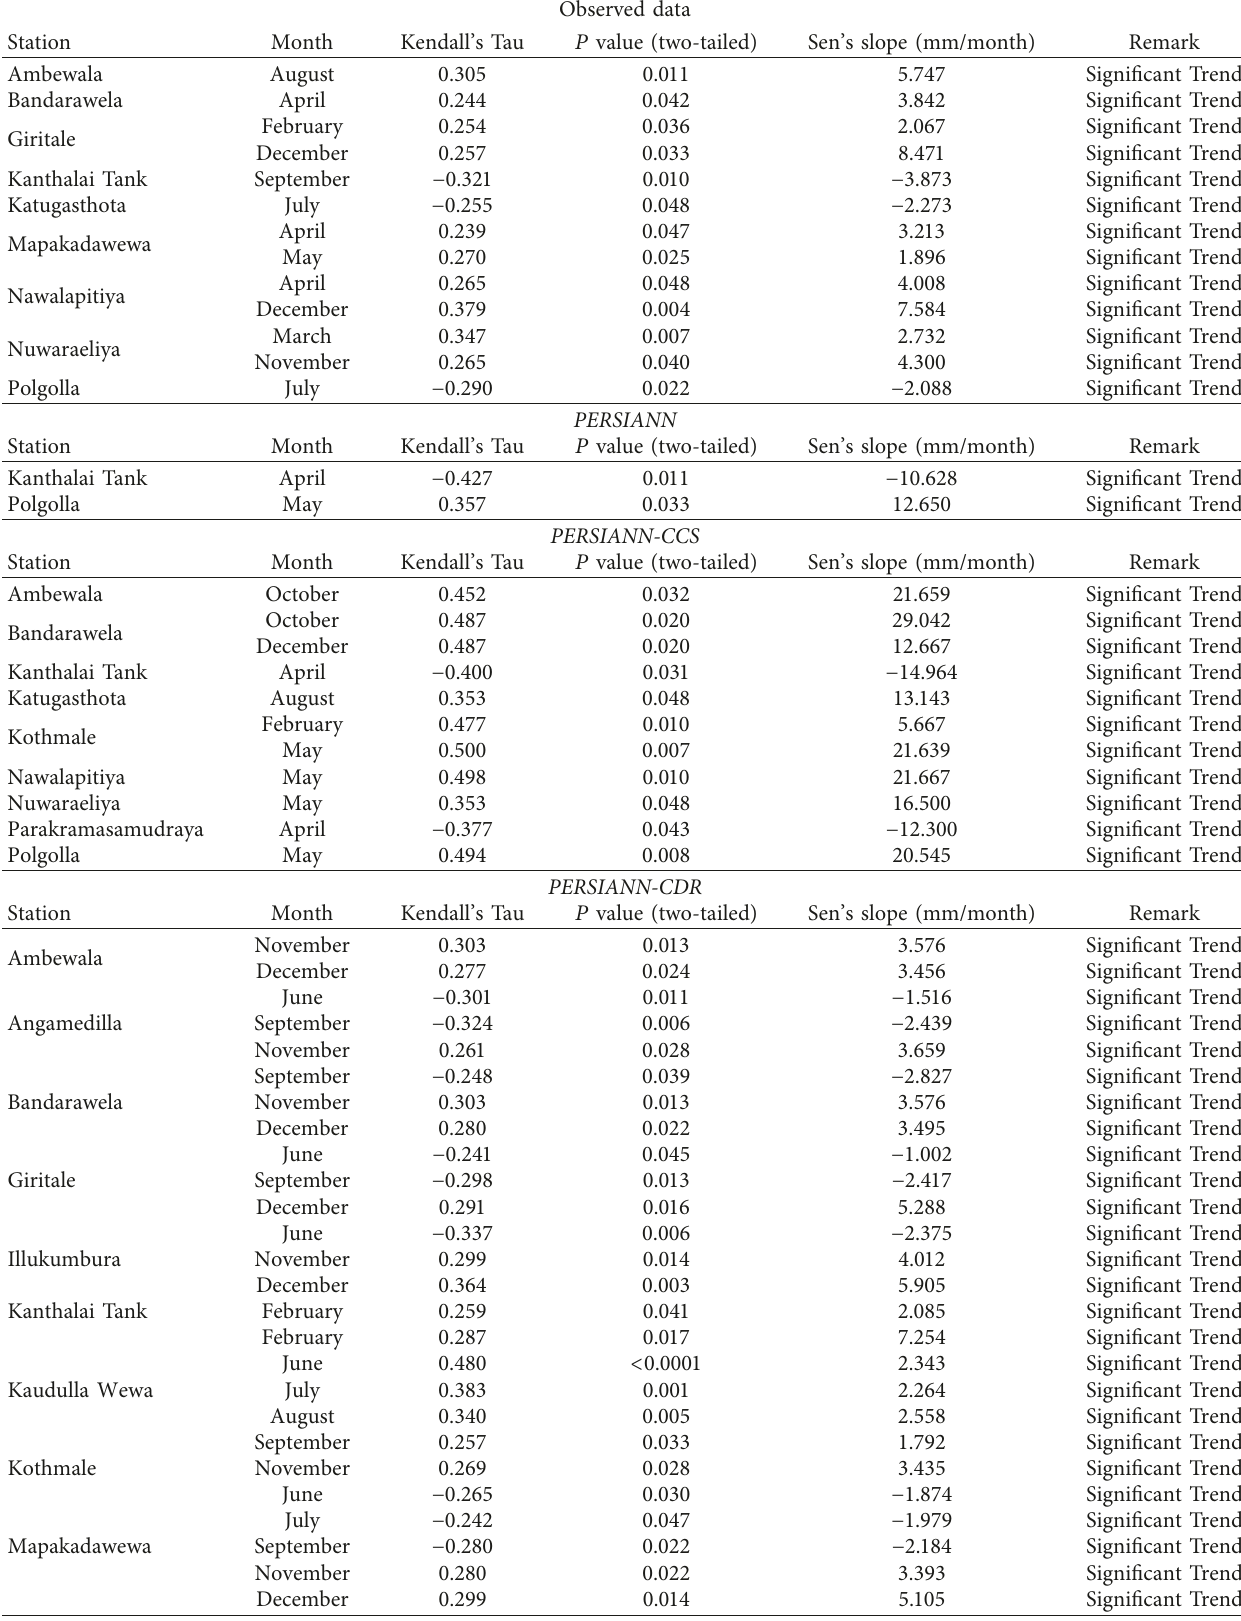
Table 6: Monthly analysis of MK test and Sen’s slope estimator significant trend